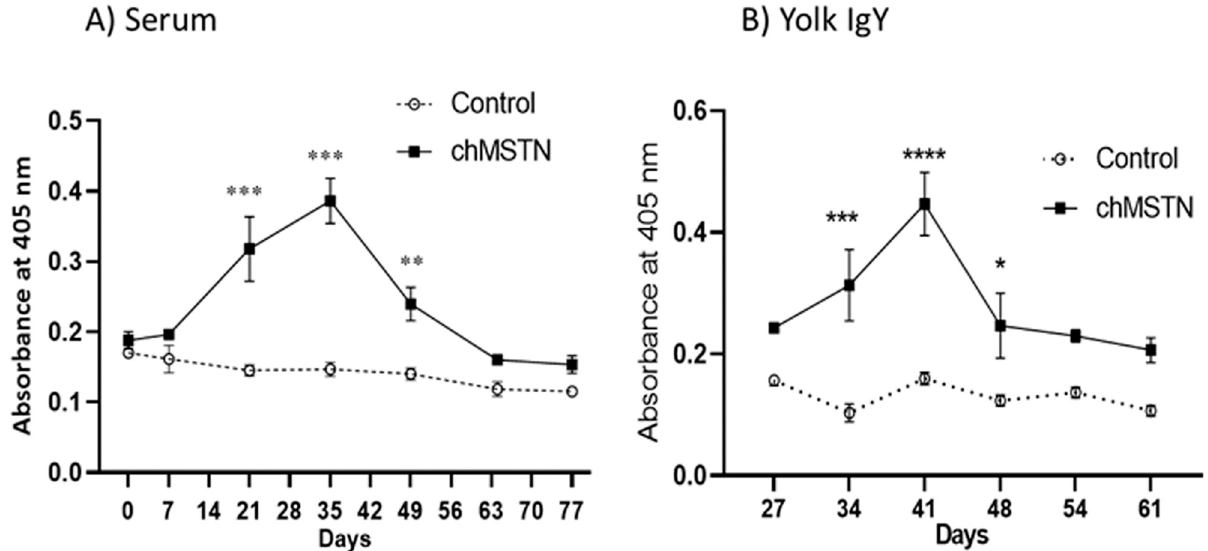
Fig 3. Titer dynamics of immunized hens and egg yolk against chMSTN. A) Diluted (1:2,000) serum from six hens of each group was used for titer determination. Arrowheads in the X-axis indicate the injection of antigen. B) 2.5 μ g/mL egg yolk IgY from three hens of each group were used. The mean difference between the Control and chMSTN groups within days was analyzed by T-test. Data are mean ± SEM.